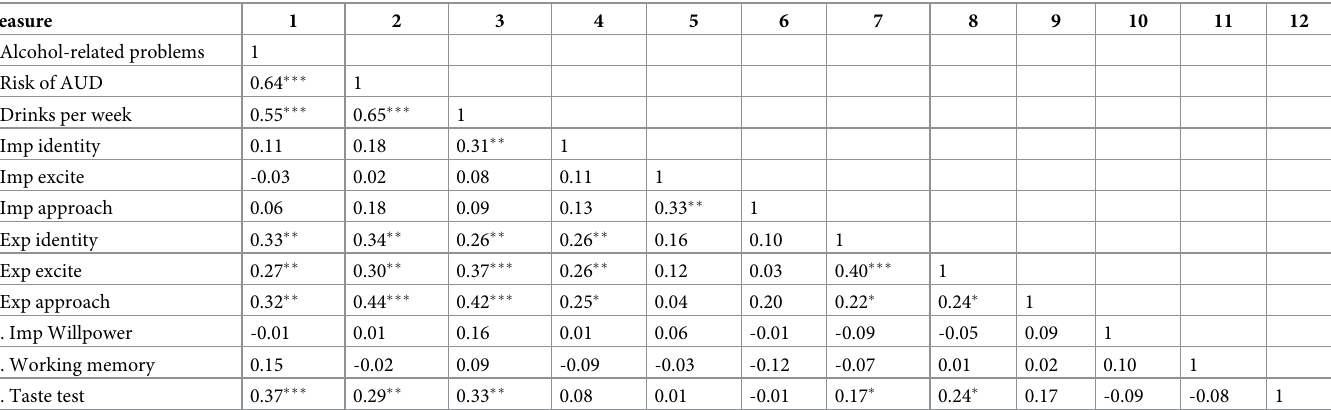
Table 2. Correlation